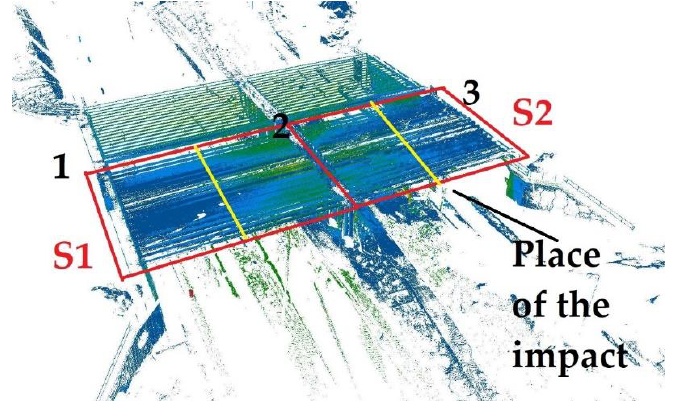
Figure 14. The sections used to compare the results for the S1 and S2 loads in the middle of each span are marked in yellow.